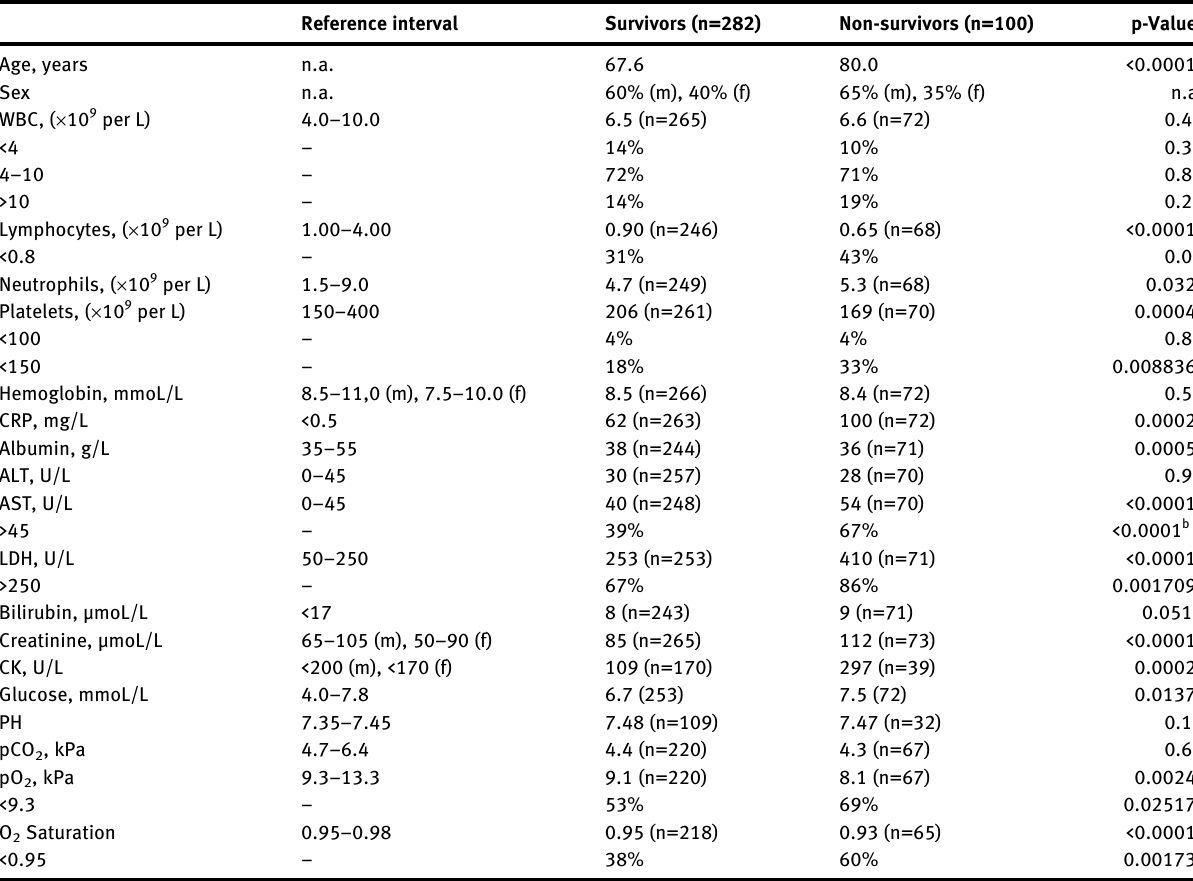
Table  : Age, sex and laboratory values of COVID-  patients on hospital admission. Reference